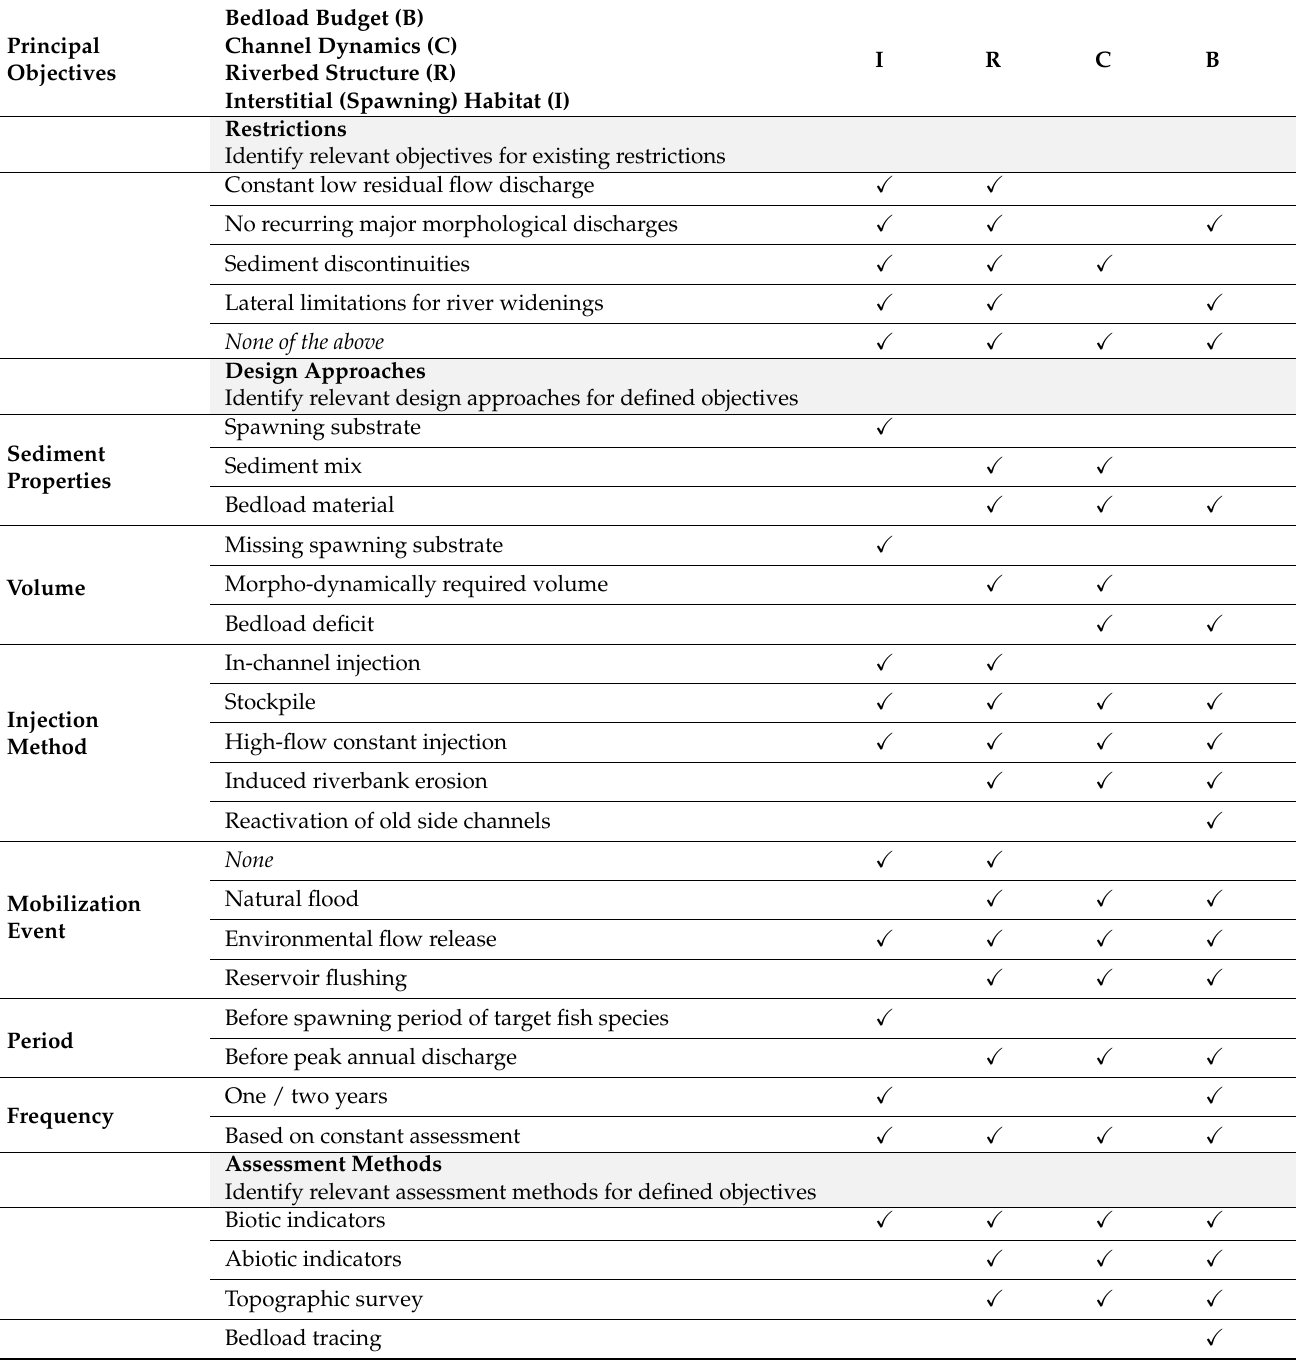
Table 1. Relevant restrictions, design approaches and assessment methods for four principal rehabilitation and management objectives of sediment augmentation